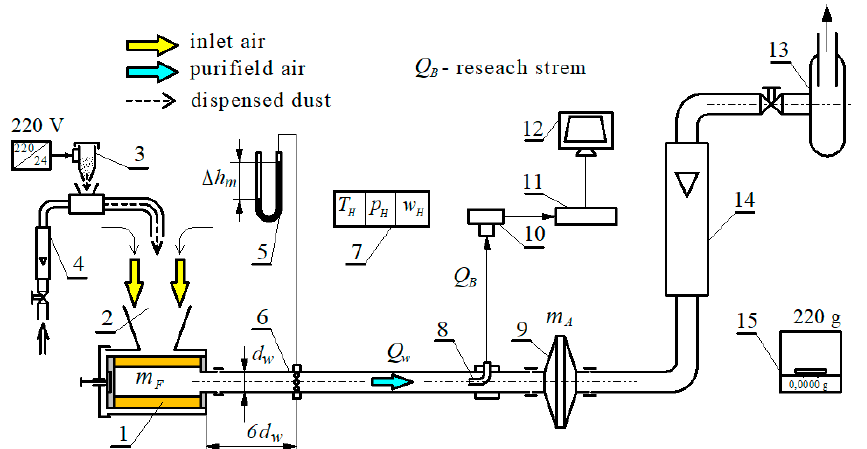
Figure 2. Diagram of the filter element test stand: 1–filter element, 2—dust chamber, 3—dust dispenser, 4—rotameter, 5—U-tube manometer, 6—measuring tube, 7—humidity, ambient air temperature and pressure measurement unit, 8—measuring probe, 9—absolute filter, 10—sensor, 11—particle counter, 12—measuring computer, 13—suction fan, 14—rotameter, 15—analytical balance.